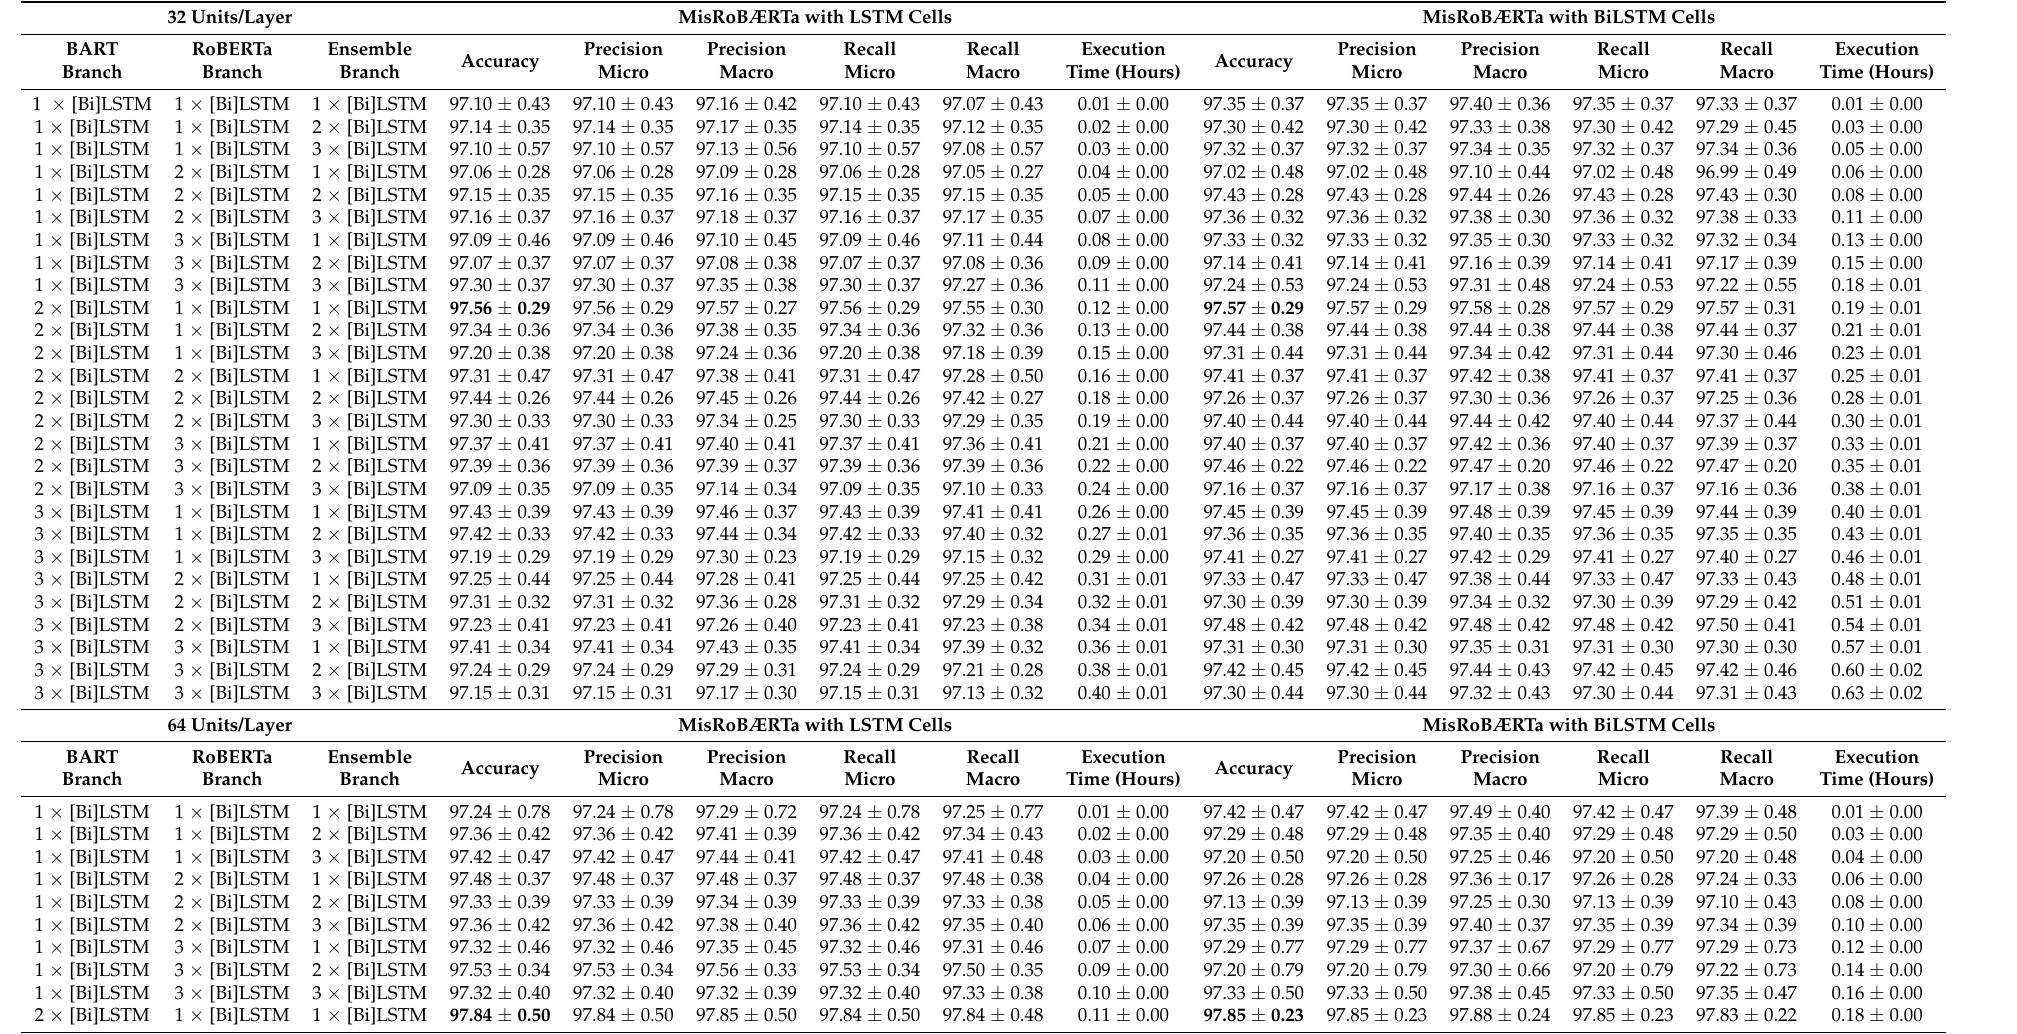
Table 7. MisRoBÆRTa ablation and sensitivity testing using the Kaggle Fake News Dataset. (Note: bold text marks the overall best